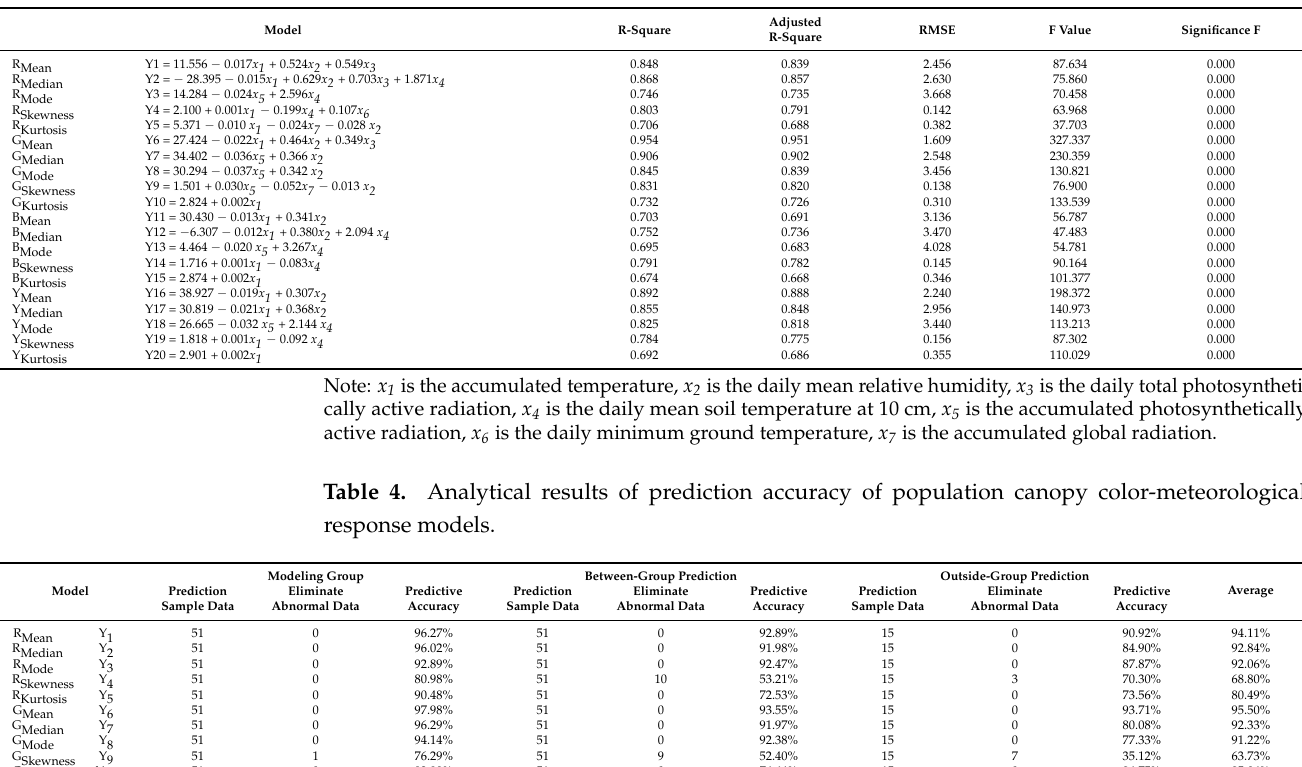
Table 3. Population canopy color-meteorological response models of BFH and their goodness of fit.